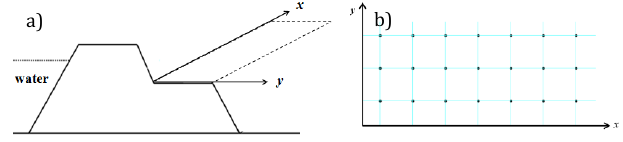
Figure 5: (a) Across sectional area of the dam and areas selected for the SP measurements; (b) a grid of 1.0 m×1.0m spacing for deployed electrodes.